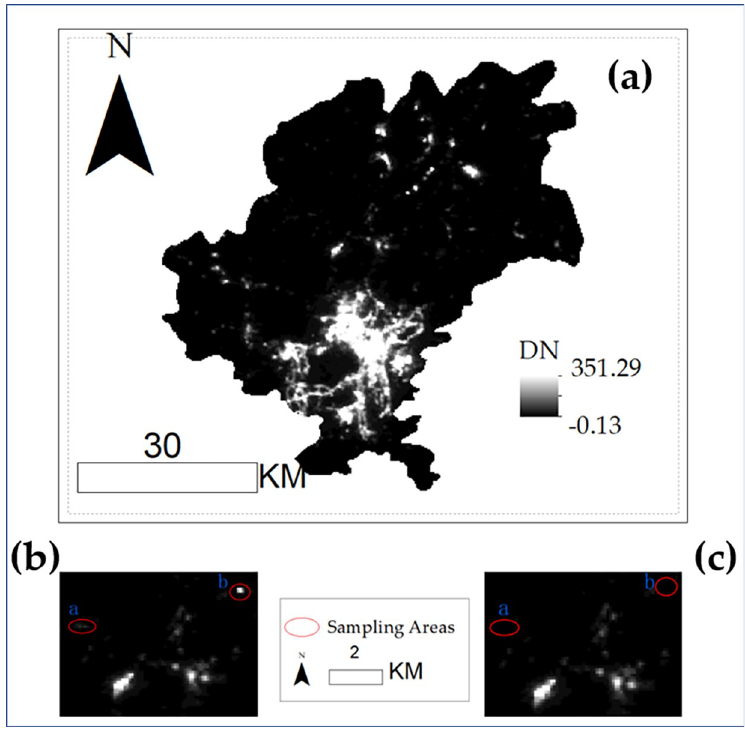
Fig 2. Original data set and examples of data preprocessing. (a) the original night-time light data in Guiyang during September, 2016; (b) the original data with abnormal values; (c) the data after data preprocessing and the abnormal points in a and b were